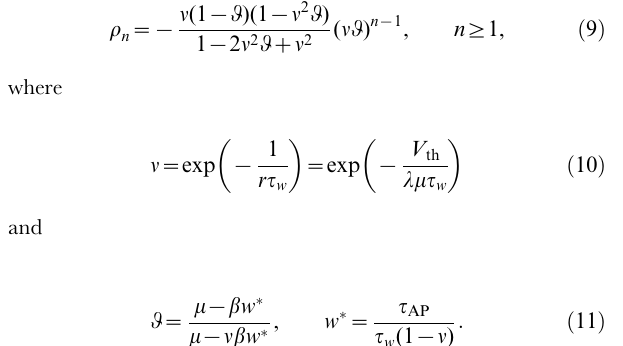
Figure 8. Serial correlation coefficient as a function of the lag between ISIs. A The case of deterministic adaptation with D ~ 0 : 01 V 2 different values of the time constant t w (as indicated in the legend). The theoretical curves, Eq. (9), are depicted by solid lines; the zero baseline is indicated by a dotted line. B The case of stochastic adaptation with N a ~ 200 for different values of the time constant t w (as in A ). The channel model, Eq. (20), is represented by white symbols, the diffusion approximation (Eq. (1)) is represented by black symbols. The theory based on the colored noise approximation, Eq. (4), is depicted by a solid line. Other parameters as in Fig. 2.